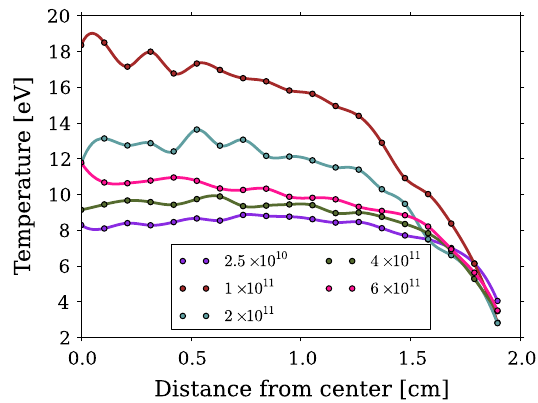
FIG. 3. The electron temperature profile of the saturated cloud 6 σ ¼ 10 11 before the bunch (25 ns spacing) in a circular pipe for i z different bunch